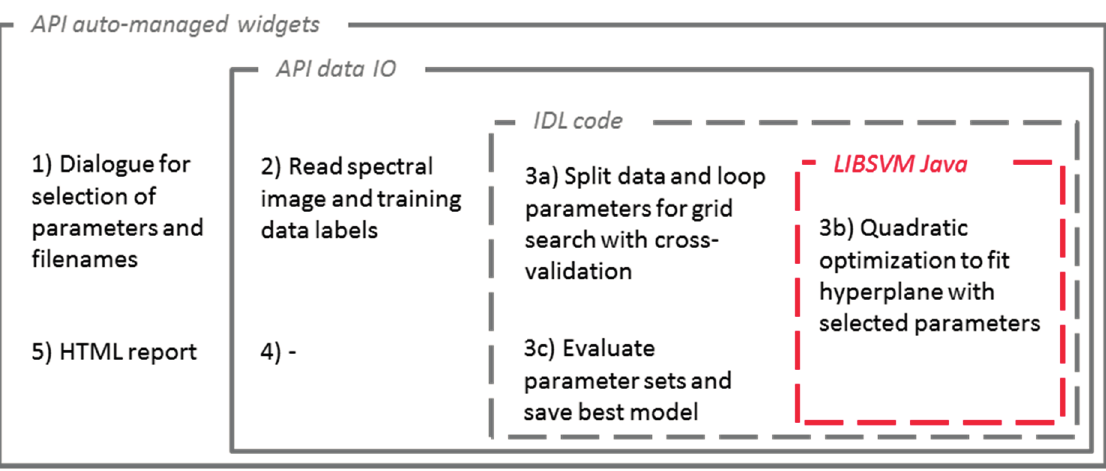
Figure 9. Framework for embedding applications for the imageSVM regression example using Java-based LIBSVM and the IDL-Java